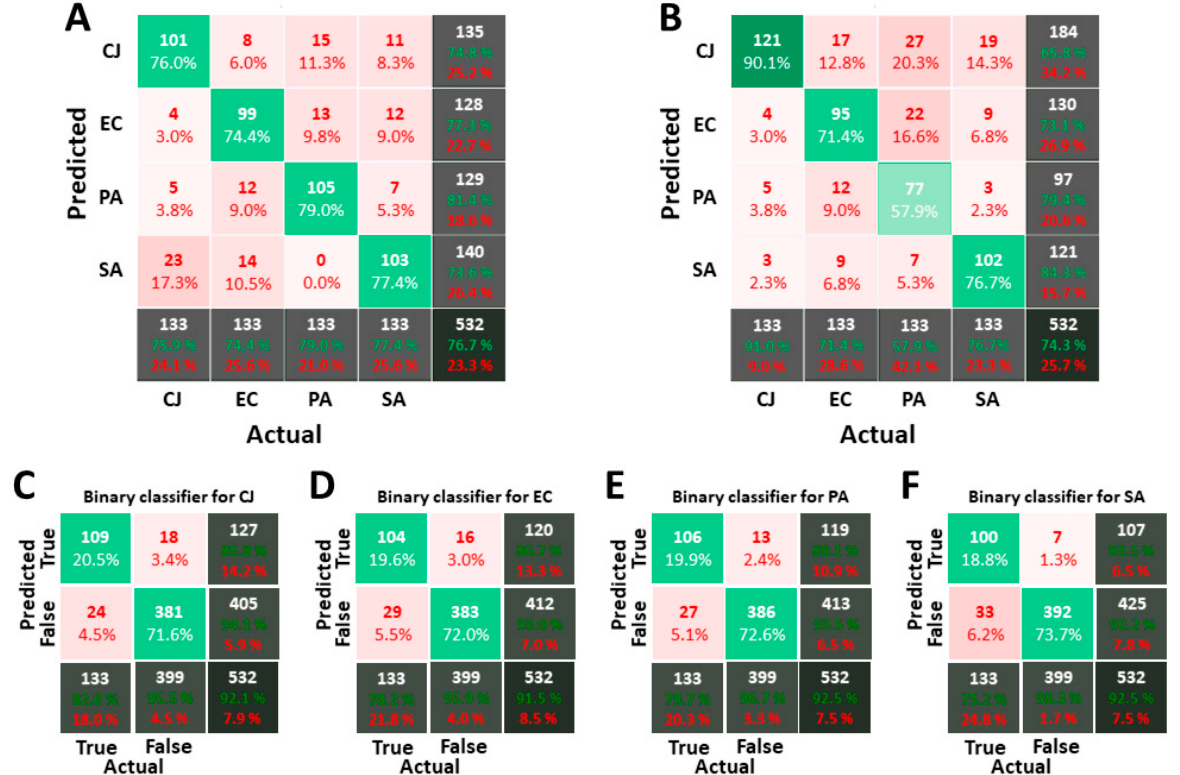
Figure 5. Confusion matrices for classifiers calculated on images acquired in PBS. ( A , B ) are the confusion matrices obtained with the 1-over-4 strategy and Random Forest (RF) for ( A ) and Support Vector Machine (SVM) for ( B ). ( C – F ) are respectively the binary classifiers for C. jeikeium , E. coli , P. aeruginosa and S. aureus . The way to interpret confusion matrices is explained in Material and Methods. For the 1-over-4 strategy, the standard deviation over 50 runs is about 1.3% on the overall score for RF and 1.5% for SVM, and about 3.5% on individual scores for RF and 3.2% for SVM. For the binary strategy, the standard deviation is about 1% for the overall score for RF and 1.2% for SVM, and 3% for the individual score of true positive for RF and 1.5% for SVM.